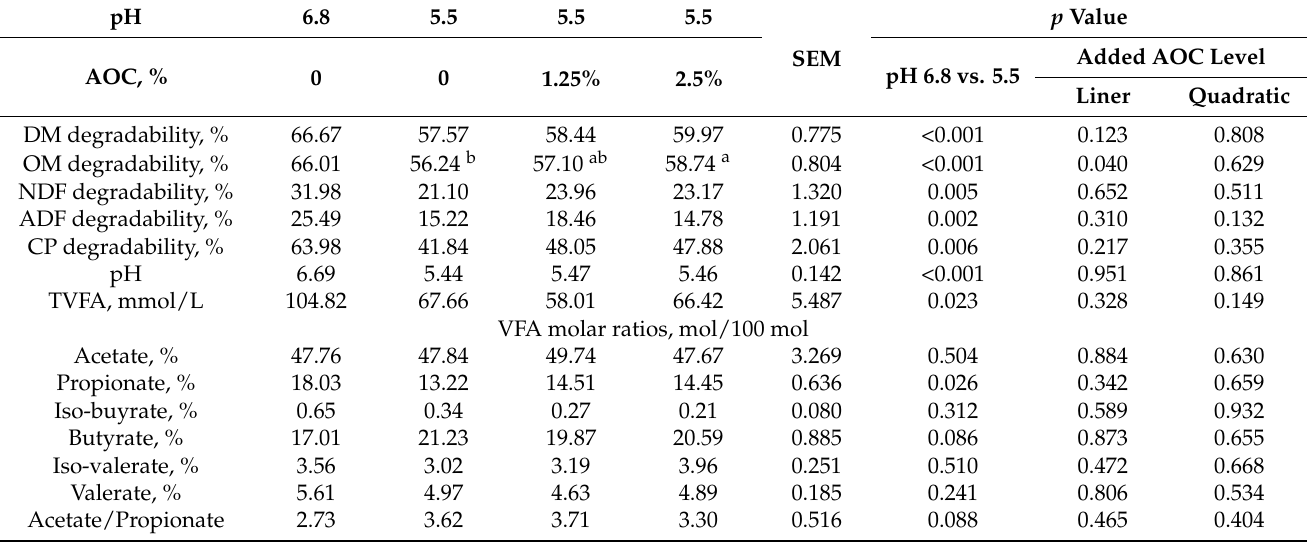
Table 4. Effects of AS pH and supplementation of AOC on nutrient digestion in RUSITEC